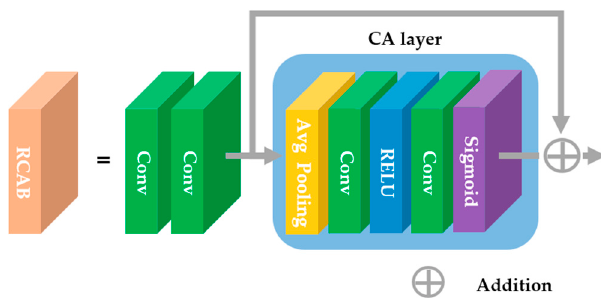
Figure 7. Overall organization of the proposed H 2 A 2 -SR model.